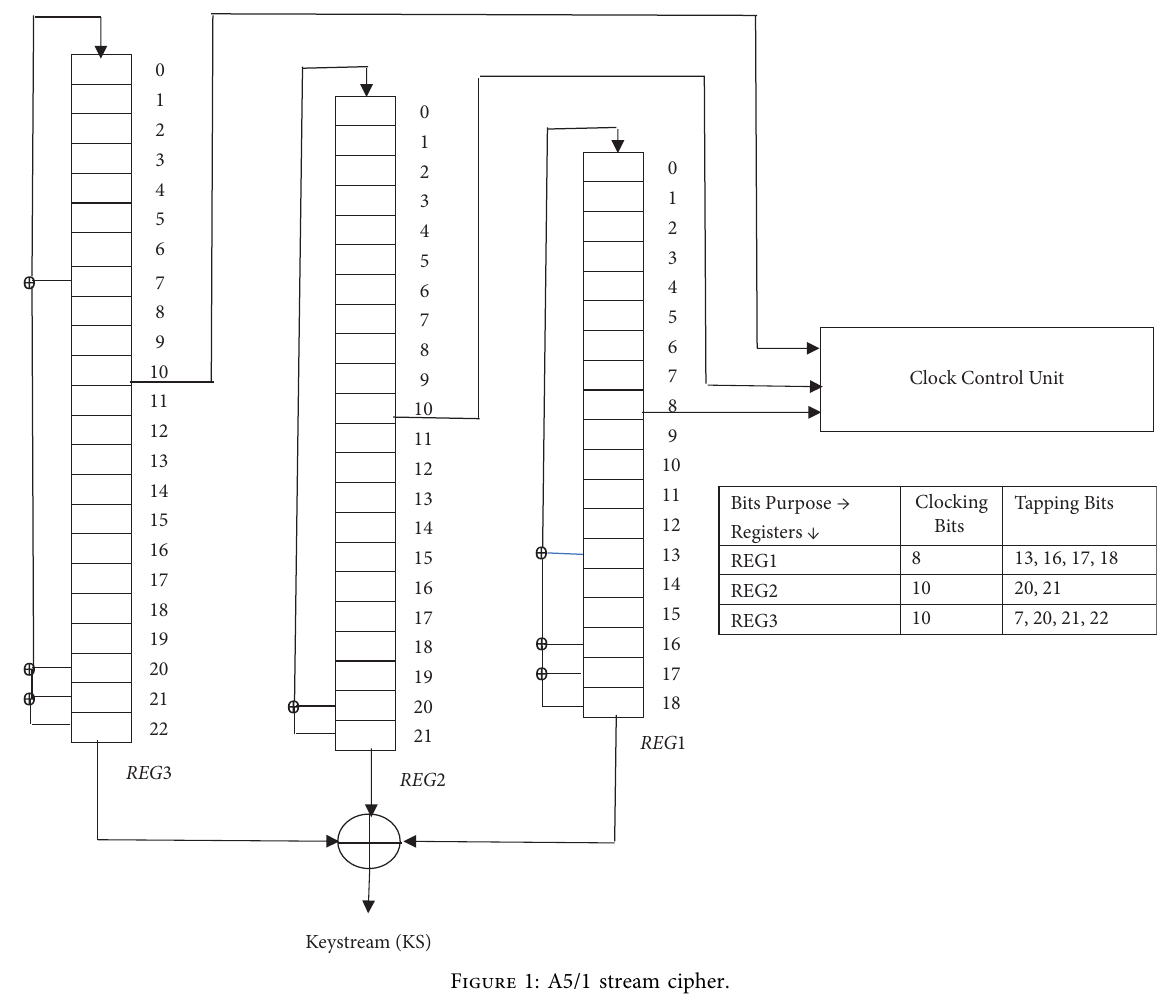
Figure 1: A5/1 stream